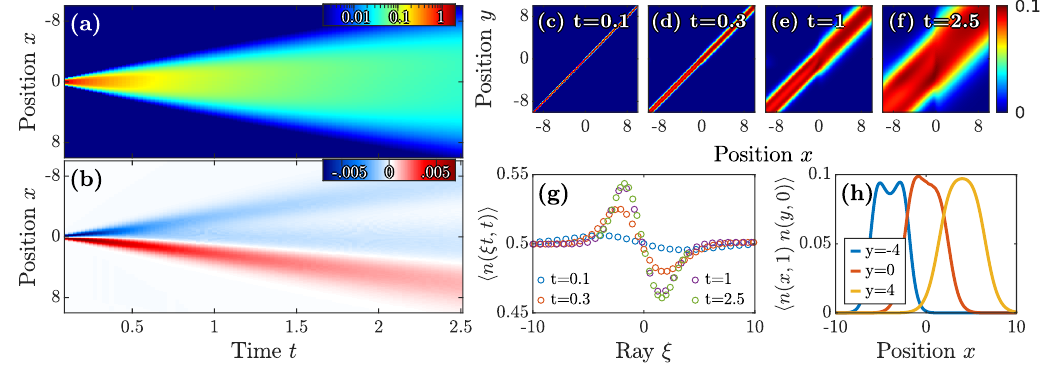
Figure 4: Two-point density correlation function of partitioning protocol in the Lieb- Liniger model. (a) Direct , dynamical two-point correlations for y = 0 plotted on logarithmic color axis. (b) Indirect , dynamical two-point correlations for y = 0. (c-f) Time-scaled correlation matrices, t 〈 n ( x , t ) n ( y ,0 ) 〉 Eul , at selected times. (g) Linear density as function of the ray ξ = x / t at selected times, t . (h) Cut-outs of the correlation matrix at t = 1 for different values of y . Simulation parameters can be found in the main